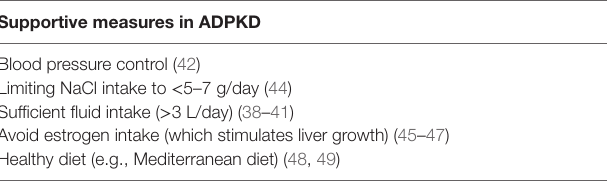
TABLe 1 | Supportive measures in autosomal-dominant polycystic kidney disease (ADPKD). Supportive measures in